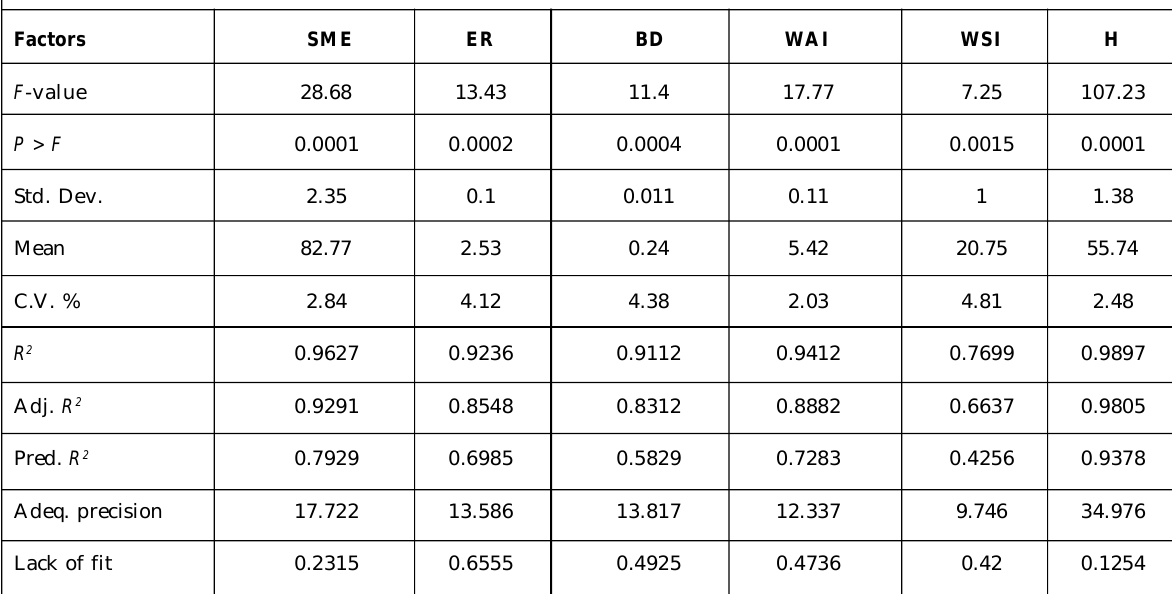
Table 3: ANOVA and model statistics for the dependent variables Factors